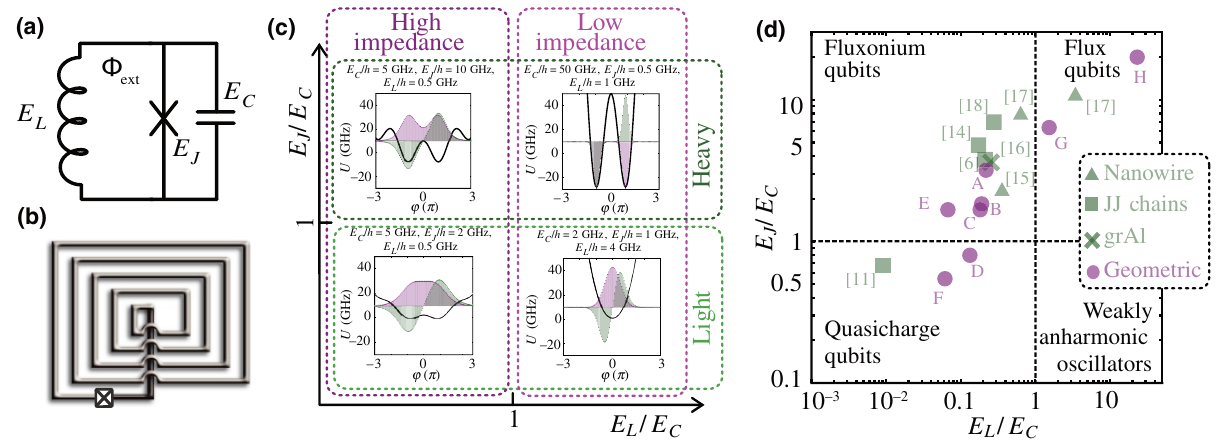
FIG. 1. The rf-SQUID qubit classification. (a) A rf-SQUID circuit with inductive energy E L , Josephson energy E J , capacitive energy E C , and external flux (cid:2) ext . (b) A sketch of a geometric rf-SQUID qubit—an exact implementation of the circuit in (a). (c) The classification scheme according to the ratios between the relevant energy scales at (cid:2) ext = 0.5 (cid:2) 0 . Each quadrant shows the qubit potential U as a function of the phase ϕ superimposed with the ground-state (purple) and excited-state (green) wave functions (scaled for visibility). Different qubit limits are determined by whether the qubit characteristic impedance Z C ∝ compared with the resistance quantum R Q ≈ 6.45 k (cid:6) and whether the qubit is heavy ( E J / E C > 1, dominated by capacitance) or light ( E J / E C < 1, dominated by tunneling). (d) The geometric rf-SQUID qubits presented in this paper (purple) alongside other qubits taken from the literature [6,11,14,25–28] (green) placed within the classification presented in (c). The four classes, identified by their limit cases, are the fluxonium qubit, the flux qubit, the quasicharge qubit, and the weakly anharmonic oscillator limit. The extracted energies and design parameters for the geometric qubits are reported in Table I.